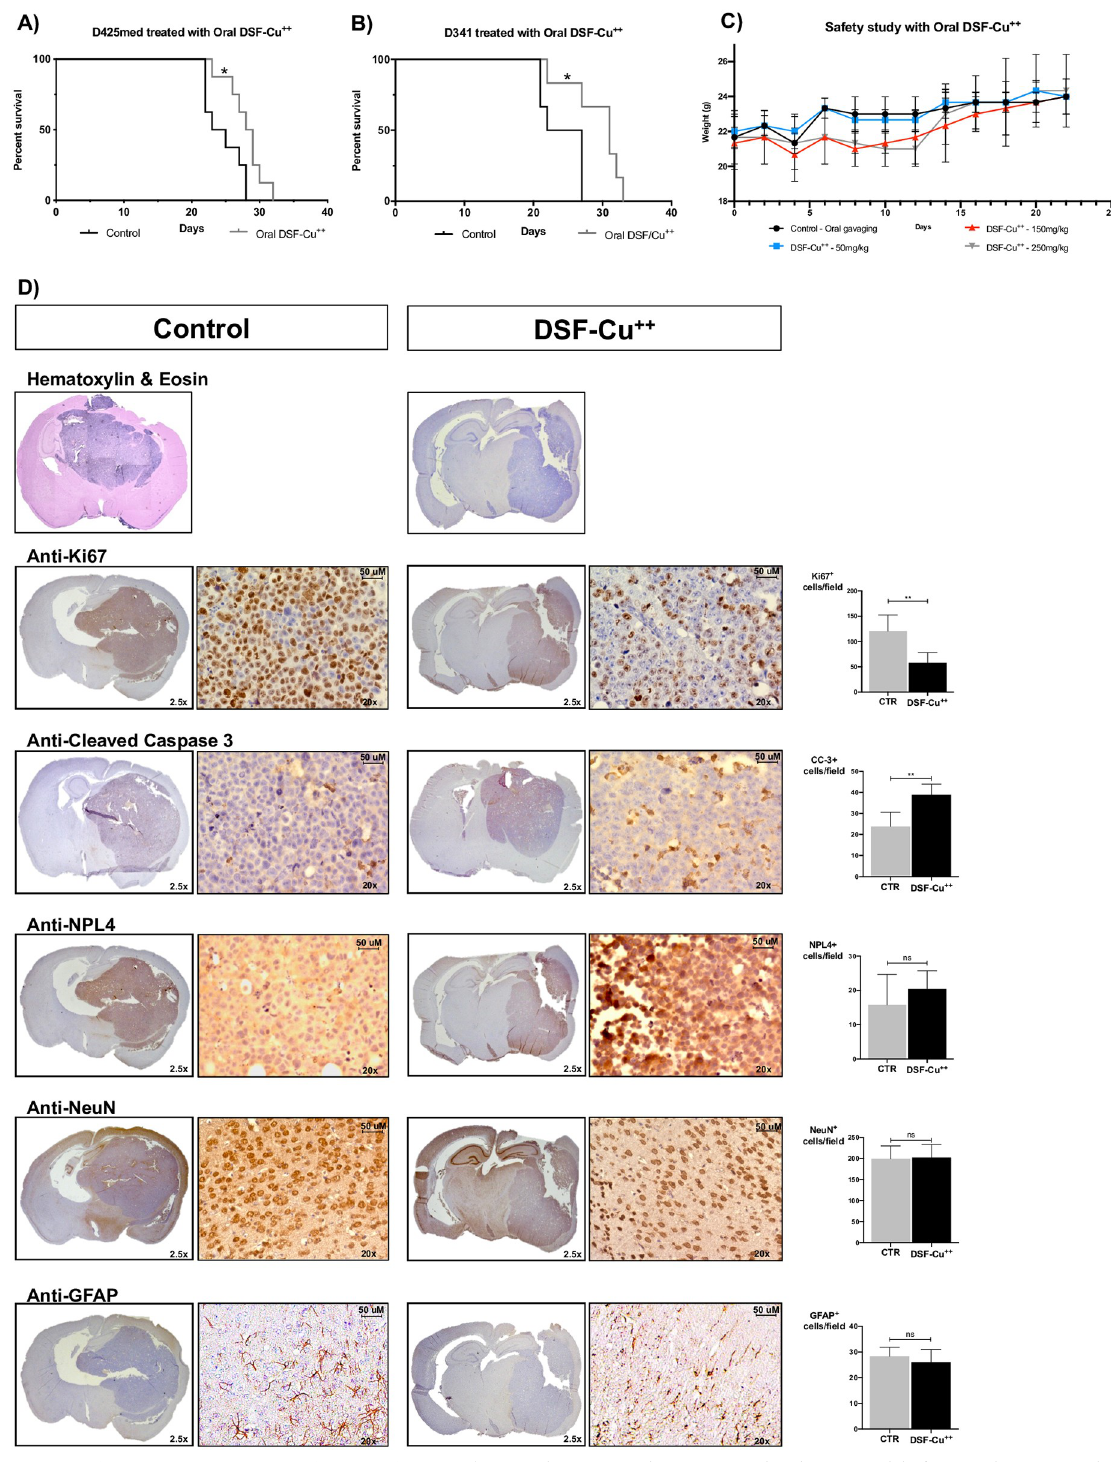
Fig 5. Kaplan-Meier curve, H&E, and IHC analyses. A-B) Survival was assessed in a D425med and D341 model of MB, with intracranial implantation of Group 3 MB cells and daily treatment with DSF-Cu ++ . In D425med-implanted animals, a median survival of 28.5 days was achieved in treated animals, compared to 24 days in controls (P = 0.02). In mice bearing D341 tumors a median survival of 31 days was achieved in the treatment group, with controls reaching 24.5 days. C) Safety study in Nu/Nu Athymic mice treated with oral gavage of water, DSF (50/150/250mg/kg) and Cu ++ (2mg/kg). D) Histopathological analysis of control and DSF-Cu ++ -treated brains. H&E showed